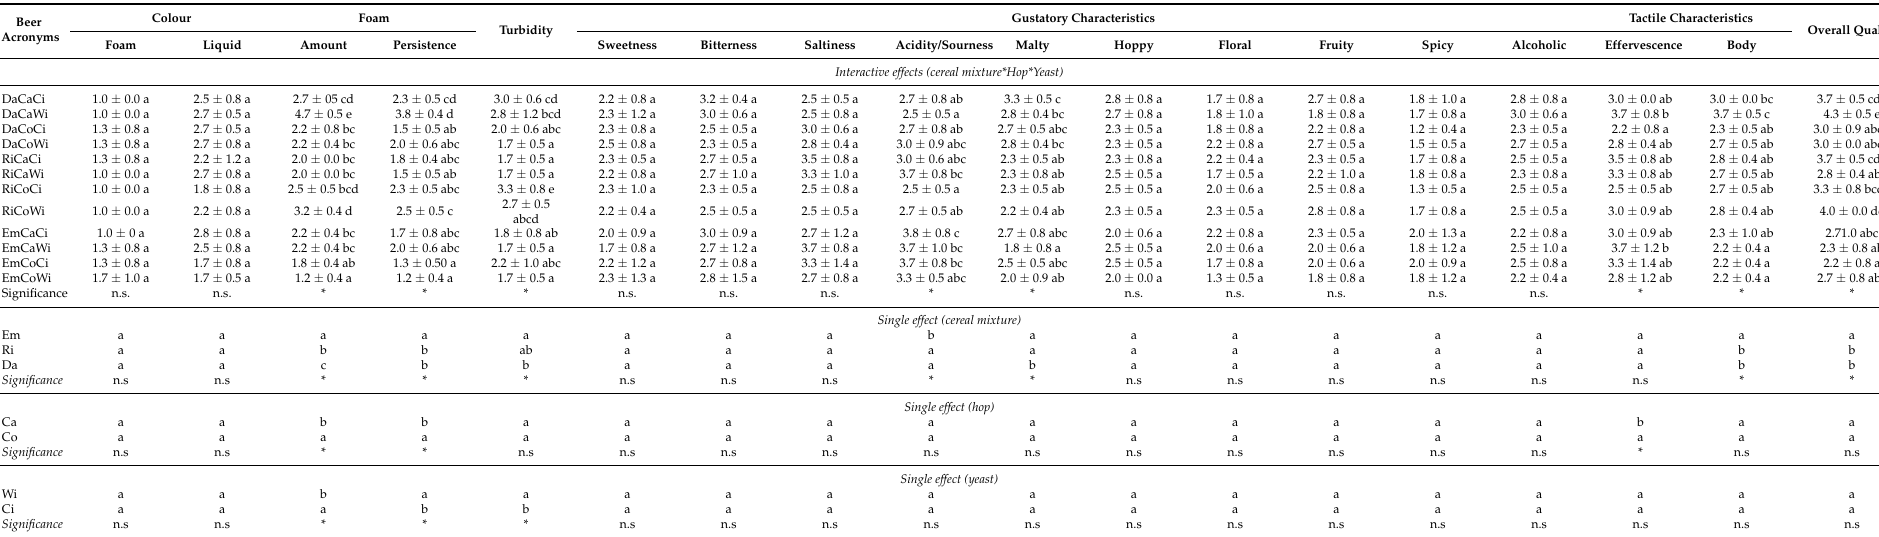
Table 6. Sensory evaluation of beer samples. Single and interactive effects of cereal mixtures, hops, and yeasts used in